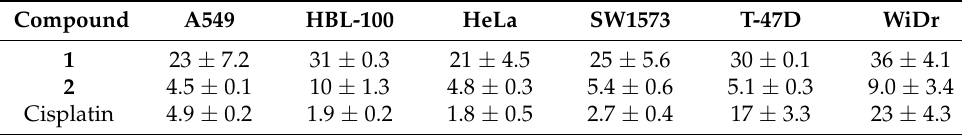
Table 5. Antiproliferative activity (GI 50 , in µ M) against human solid tumor cell lines.